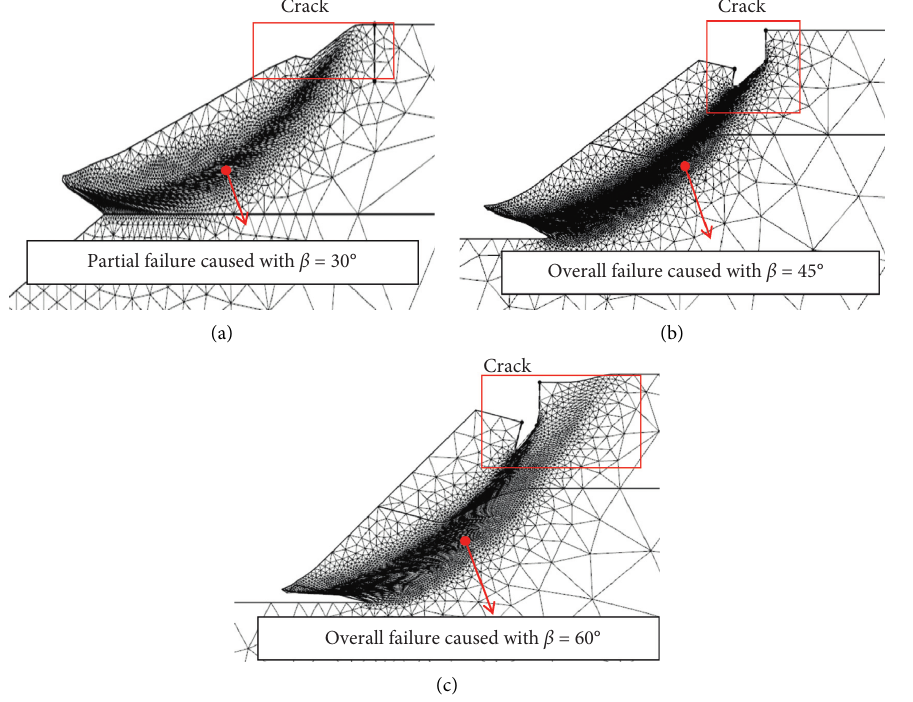
Figure 9: The failure surface of slope at different slope angles. (a) β � 30 ° . (b) β � 45 ° . (c) β � 60 ° .